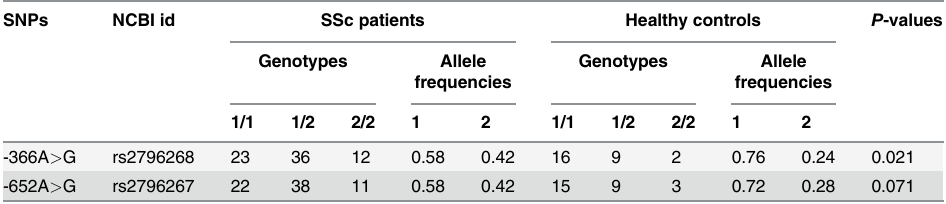
Table 3. Allele frequencies of two SNPs in MCP gene promoter. SNPs NCBI id SSc patients Healthy controls P -values Genotypes Allele Genotypes frequencies